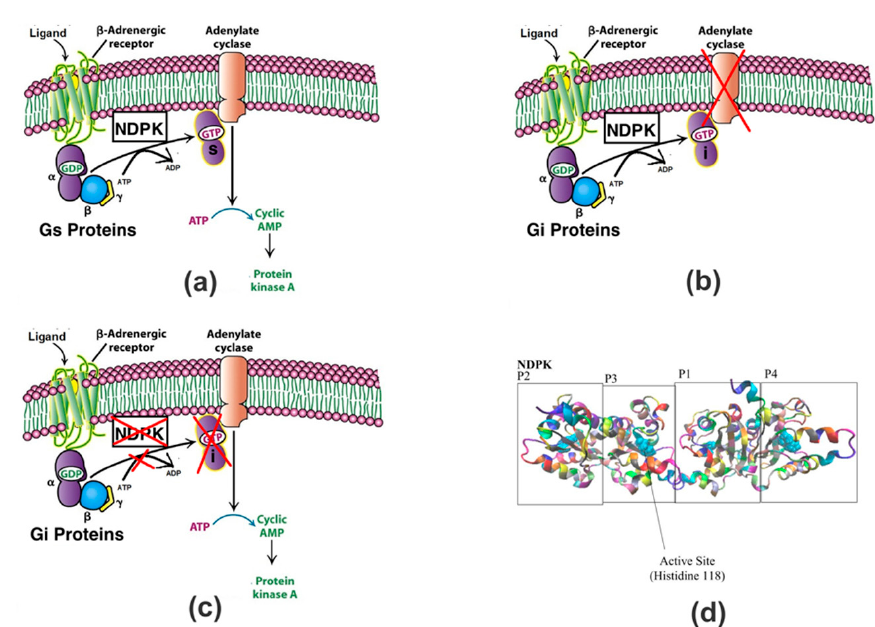
Figure 1. ( a ) The role of nucleoside diphosphate kinase (NDPK) in a non-failing heart. Typically, G βγ binds with G α and this guanosine diphosphate (GDP(s)) as a whole is further converted to Guanosine -5 ′ -Triphosphate (GTP(s)) with the help of NDPK that triggers the adenylate cyclase in a dependent pathway to synthesize the cAMP; ( b ) Role of NDPK in a failing heart. During heart failure, the same NDPK inhibits the adenylate cyclase activity due to its increased interaction with cAMP inhibitory membrane proteins in the form of GDP(i), which is the result of the binding between G βγ and G α (i), and the eventual conversion of GDP(i) to GTP(i); ( c ) Potential effects that may result due to graphene oxide inhibiting NDPK. The inhibition of NDPK by graphene oxide during heart failure can prevent the suppression of cAMP formation through the dependent pathway. Adenylate cyclase activity is resumed because the NDPK molecules reacting with G i proteins are inhibited and the faulty GTP(i) is not formed anymore. The NDPK independent pathways continue to produce cAMP without the suppression that was occurring due to NDPK molecules reacting with the G i proteins; ( d ) The structure of NDPK and the active sites on each monomer. Monomers are defined by labels: P1, P2, P3, P4 in Visual Molecular Dynamics (VMD)—a molecular graphics program. (Figures a–c are modified from Source: Biochemistry, Sixth Edition © 2007 W.H Freeman and